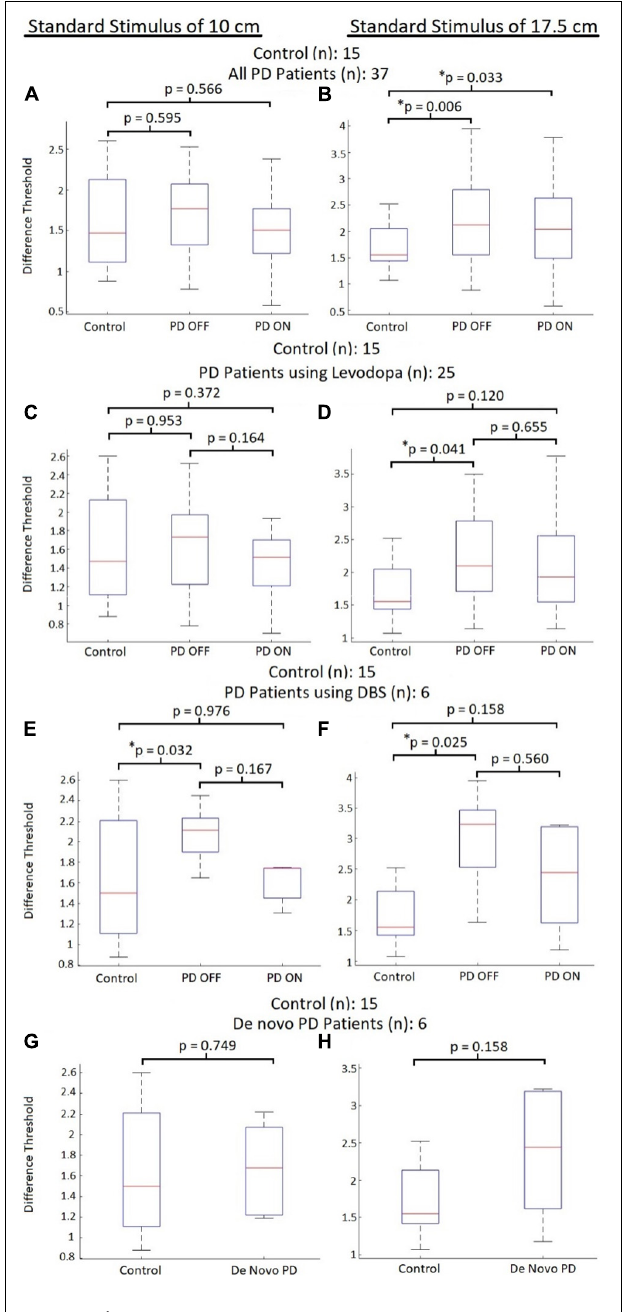
FIGURE 2 | Control vs. PD absolute perceptual ability comparisons. Comparison of visual displacement perceptual abilities (quantified using DL) between control participants and PD patients subdivided into groups based on therapeutic treatment. Red lines represent median DL for each group, with bars representing the data spectrum. (A) Comparisons to all PD participants with the 10 cm standard. (B) Comparisons to all PD participants with the 17.5 cm standard. (C) Comparisons to PD participants using levodopa with the 10 cm standard. (D) Comparisons to PD participants using levodopa with the 17.5 cm standard. (E) Comparisons to PD participants using DBS with the 10 cm standard. (F) Comparisons to PD participants using DBS with the 17.5 cm standard. (G) Comparisons to de novo PD participants with the 10 cm standard. (H) Comparisons to de novo PD participants with the 17.5 cm